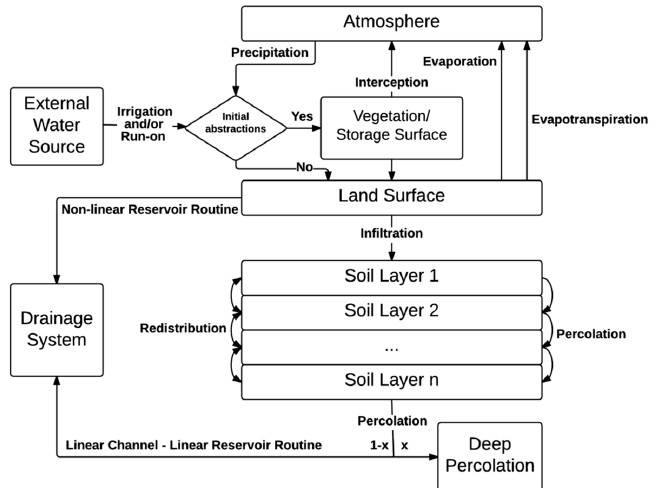
Figure 2. Conceptual representation of the physical processes simulated in IHMORS (extracted from [14]).